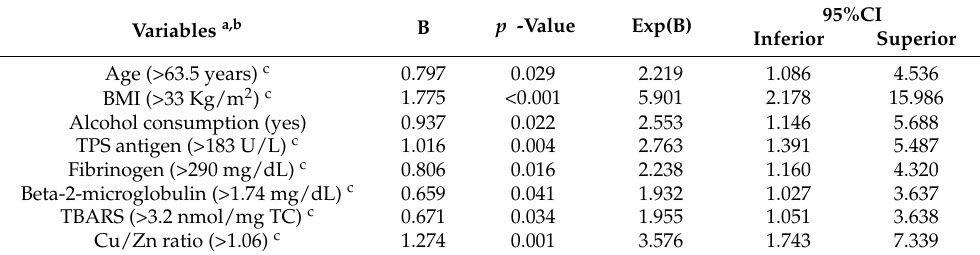
Table 3. Binary logistic regression model based on clinical variables, inflammatory markers, and redox parameters for the presence of a non-dipper blood pressure